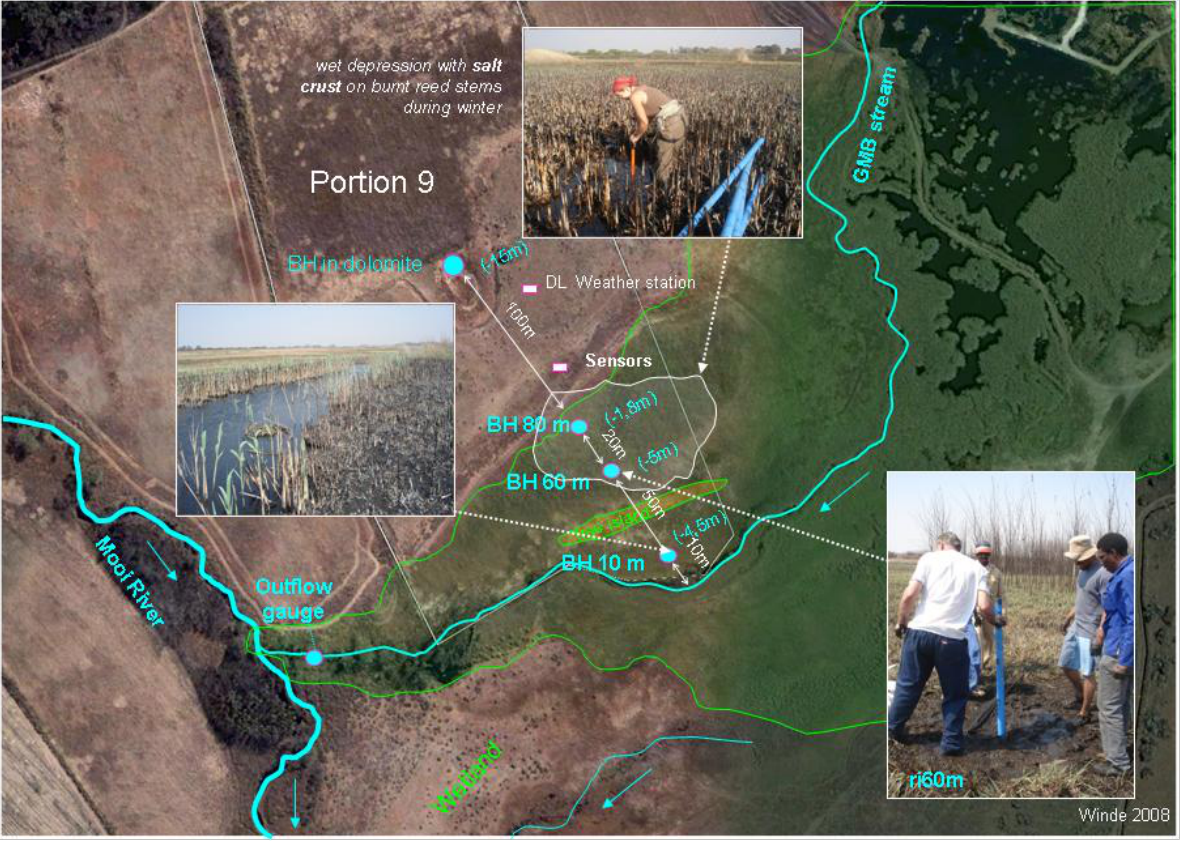
Figure 18. Location and structure of the borehole transect in peat installed at portion 9 (underlying satellite image retrieved from Google map, September